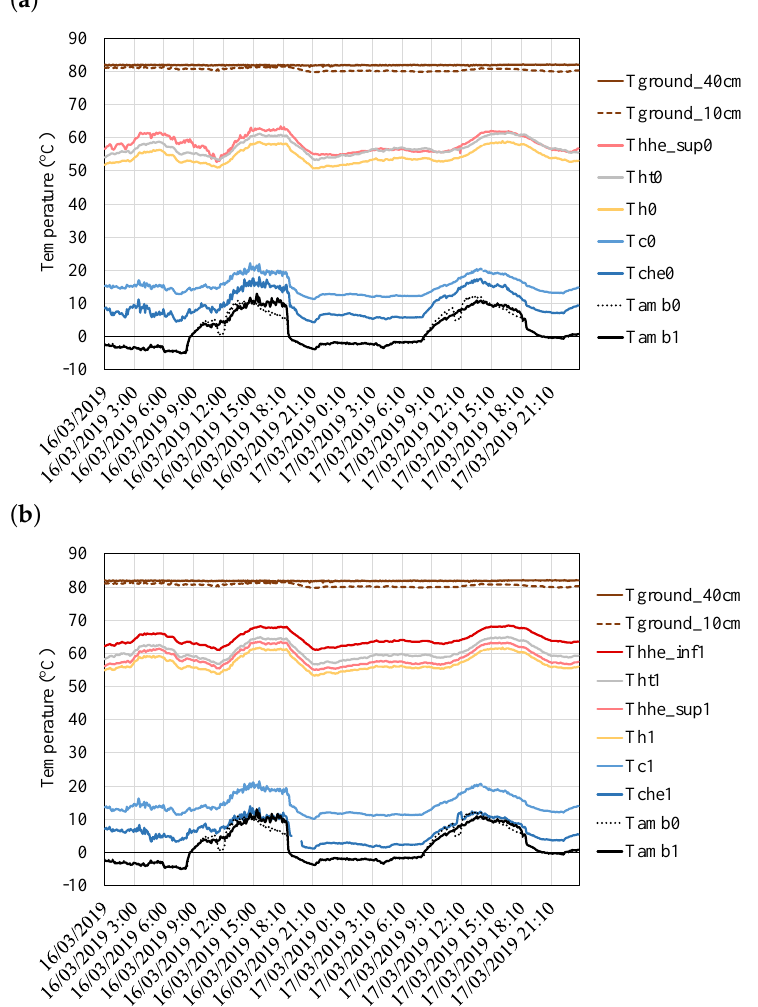
Figure 12. Temperature distribution of the prototype, separated into ( a ) the unsealed thermoelectric module and ( b ) the sealed one. T ground represents the ground temperature measured at depths of 40, 10 and 5 cm; T hhe _ inf and T hhe _ sup are the temperatures in the lower and upper part of the hot side heat exchanger’s tubes respectively; T ht is the temperature of the aluminum plate of the hot side heat exchanger; T h and T c represent the hot and cold side of the modules; T che is the temperature at the tubes of the cold side heat exchanger; and finally T amb measures the ambient